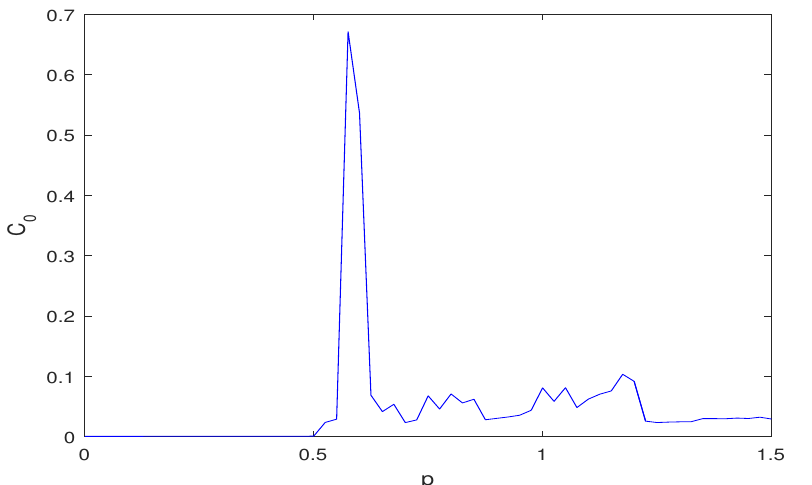
Figure 5. The C 0 complexity versus P of the D.T.H.N.N with incommensurate V.O